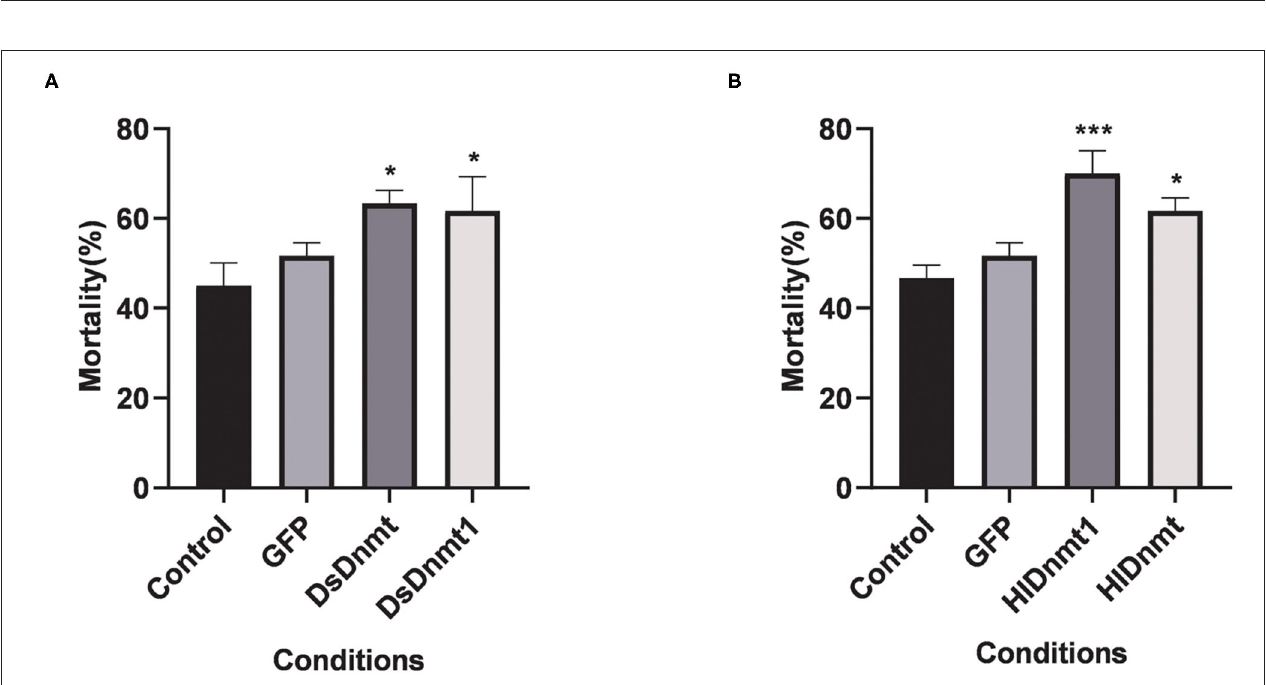
FIGURE 5 | Effect of double-stranded RNA treatment on expression of Dnmts in D. silvarum (A) and H. longicornis (B) . The expressions of Dnmts were significantly decreased post 24h after the injection of respective dsRNAs compared with expression in the controls. The results are expressed as the means ( n = 3) ± SEM. The asterisks above bars indicate significant difference based on one way ANOVA followed by Turkey’s test, *** P < 0.01. GFP represents the green fluorescent protein gene.